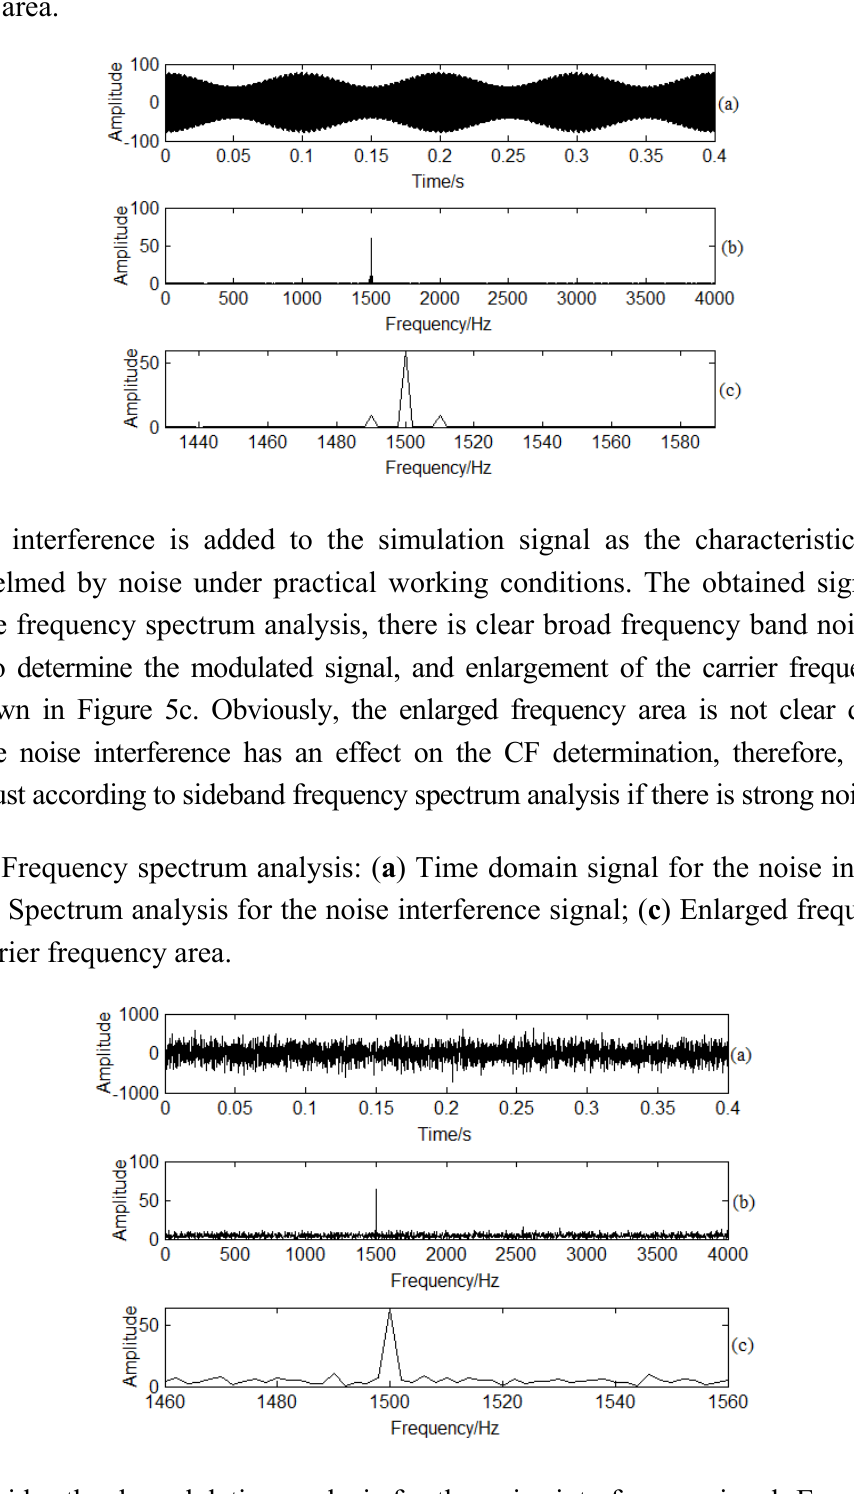
Figure 4. Signal demodulation analysis: ( a ) Time domain signal for the simulation signal; ( b ) Spectrum analysis for the simulation signal; ( c ) Enlarged frequency area for the carrier frequency area.